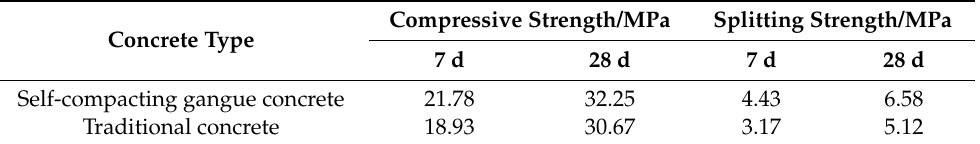
Figure 22. Field-application effect. Table 11. Field-test intensity.